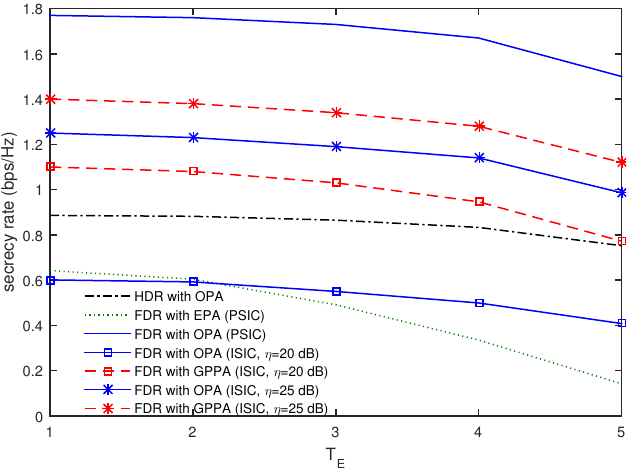
Figure 5. Comparison of secrecy rates as a function of T E when T = 6, d Ex = 150 m, d E = 10 m, and P = 60